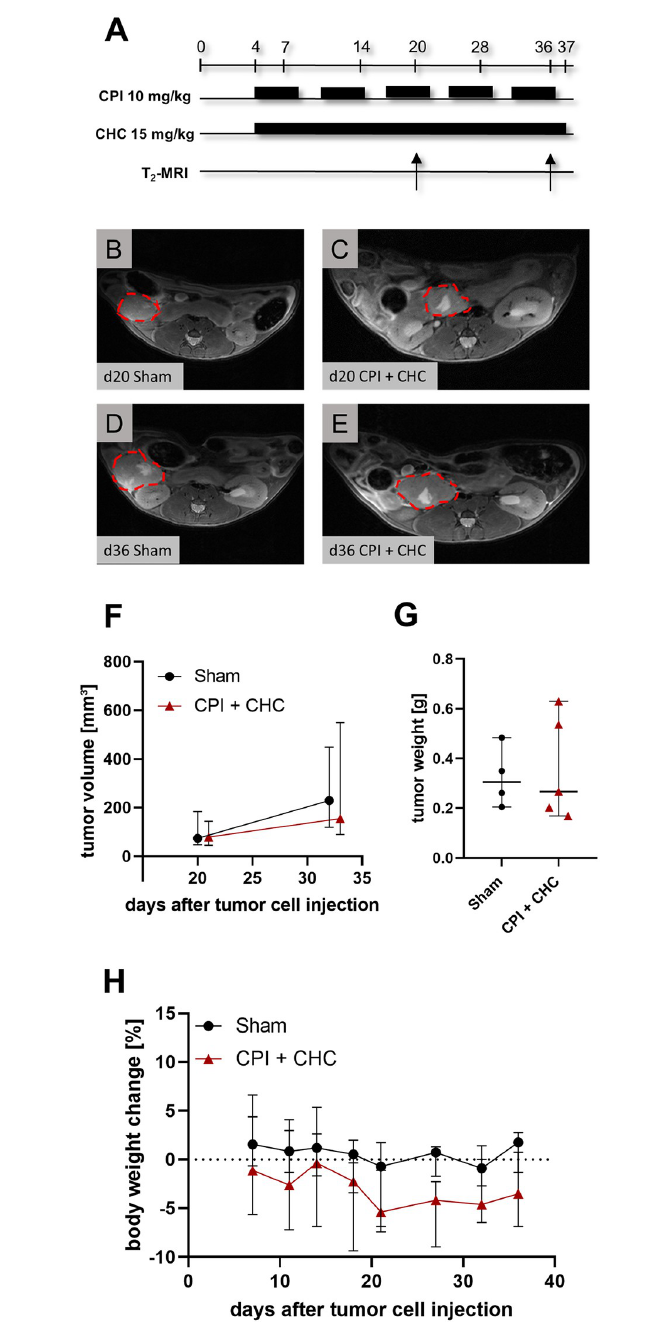
Fig 4. The combinatorial treatment of CPI + CHC (solvent: 30% PEG 300) did not inhibit the tumor growth in vivo . ( A ) CPI was injected 5x weekly at a dose from 10 mg/kg and CHC (15 mg/kg) was applied daily, from day 4 until day 37 after tumor cell injection. Both therapeutics were dissolved in 30% PEG 300 (30% Polyethylene glycol 300), 1% Tween, PBS. ( B-E ) MRI was performed on day 20 and 36 after tumor cell injection, as indicated by exemplary images (tumors are framed by a red dotted line). ( F ) The tumor volume was evaluated for the combinatorial treatment (CPI + CHC) and the sham treatment. ( G ) The weight of the tumors was quantified after sacrificing the mice on day 37. ( H ) The body weight change of mice quantified at the indicated days during the treatment period. Biological replicates: F-H: Sham: n = 4, CPI + CHC: n = 5.